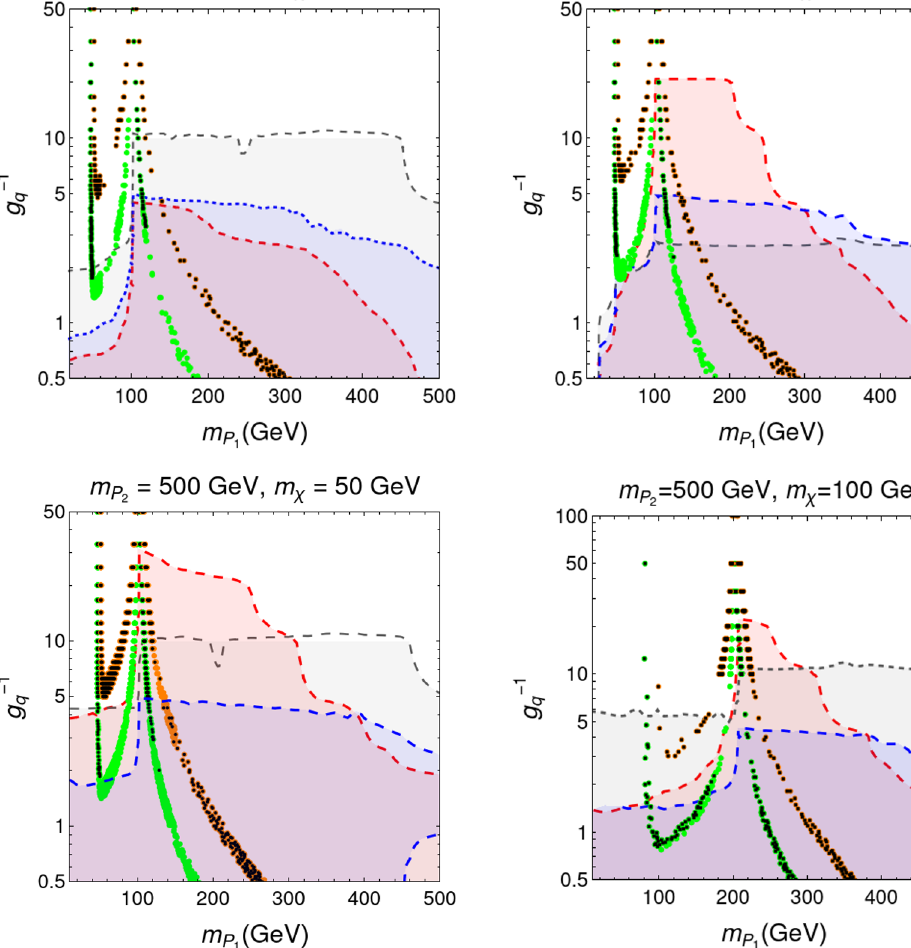
Figure 9 . Constraints on the model that originate from dark matter relic density and indirect detection, shown together with HL-LHC expectations for a luminosity of 3 ab − 1 . The results are (cid:1) for the four scenarios discussed in the rest of section 4. The points shown in the plane (cid:0) m − 1 P 1 , g q appearing in light green are associated with a relic density satisfying Ω h 2 = 0 . 12 ± 10% (assuming standard cosmology), whereas the dark green points are additionally allowed by indirect detection results. Points shown in orange correspond to cosmological scenarios in which there was a period of matter domination in the early universe with a dilution factor of 10. The shaded regions represent 95% confidence level expected exclusions from mono-jet (grey), mono-Higgs (red) and t ¯ t + /E analyses in 3 ab − 1 of HL-LHC data, as extrapolated from the searches of refs.